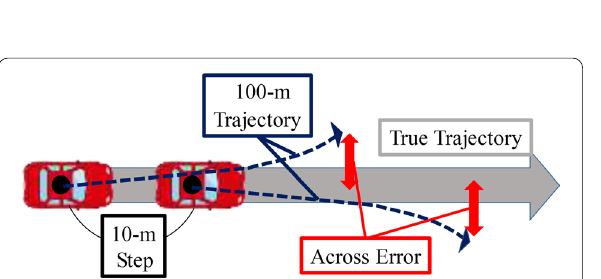
Fig. 19 Overview of trajectory evaluation